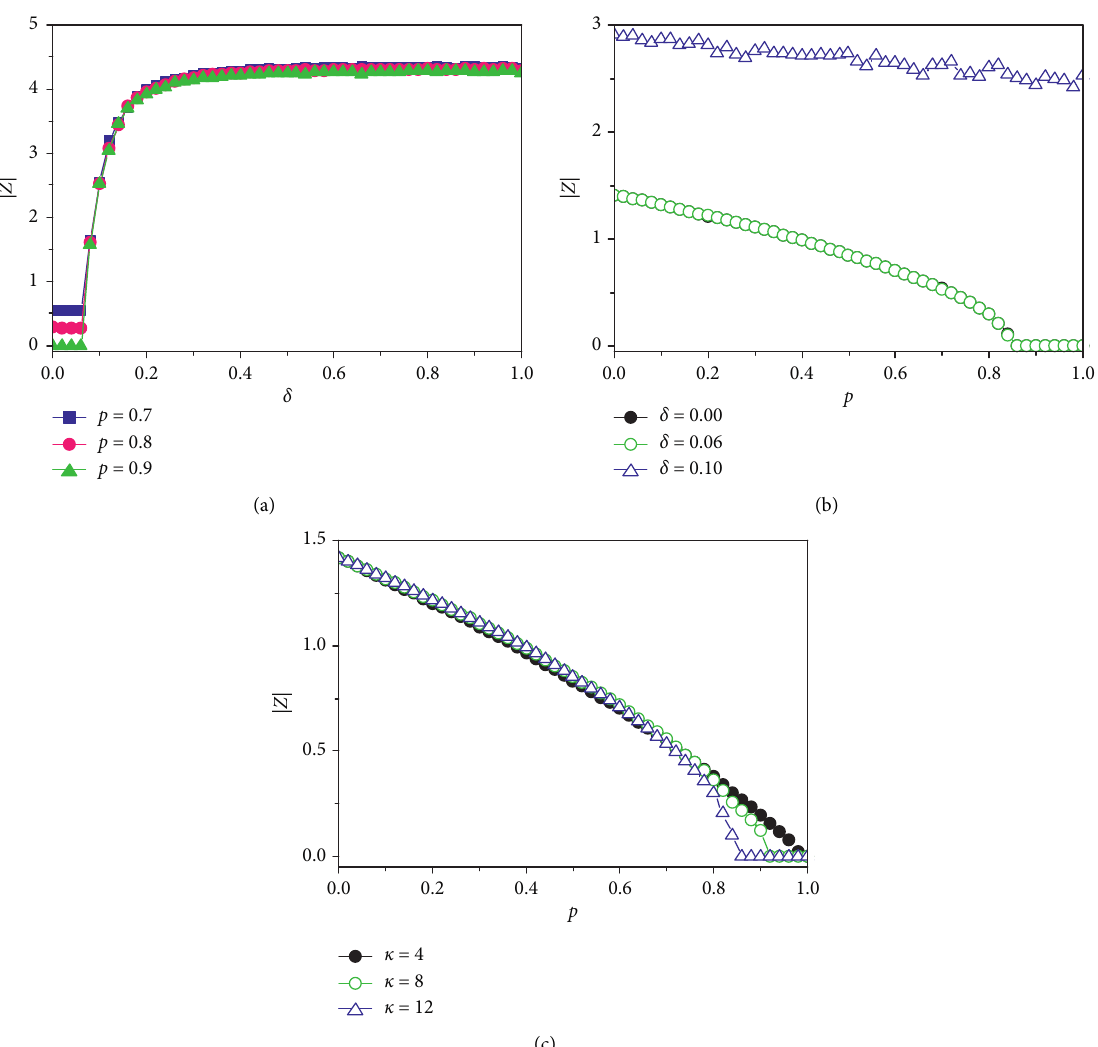
Figure 8: (a) The order parameter | Z | as a function of the time delay δ in the small-world networks for p � 0 . 7, 0.8, and 0.9, respectively. (b) The order parameter | Z | versus the ratio of inactive ratio p for different values of δ . κ � 12 . 0. (c) The order parameter | Z | against p with different coupling strength. δ � 0 .